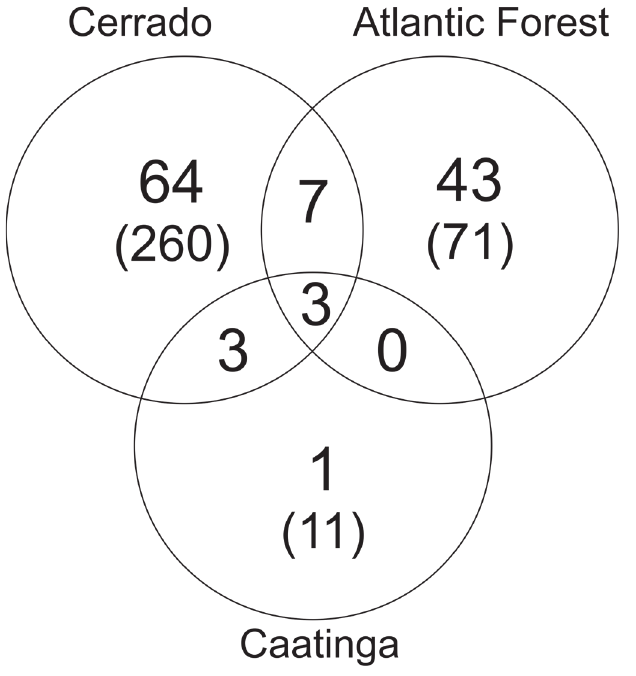
Fig. 2. Venn diagram of the distribution by biome of species of Orchidaceae recorded for karsts from Brazil. The number of samples for each biome is indicated in